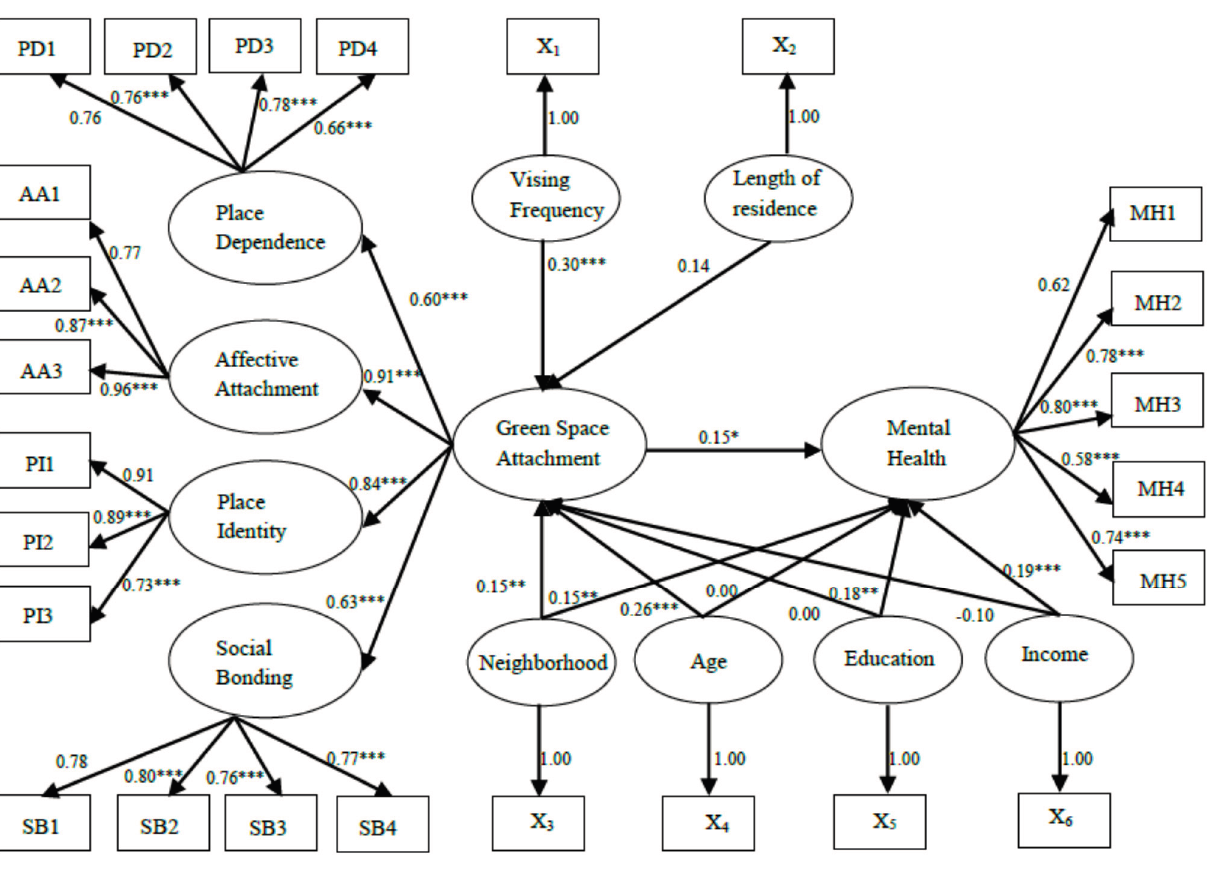
Figure 3. Standardized results of the structural equation modelling, * p < 0.10, ** p <